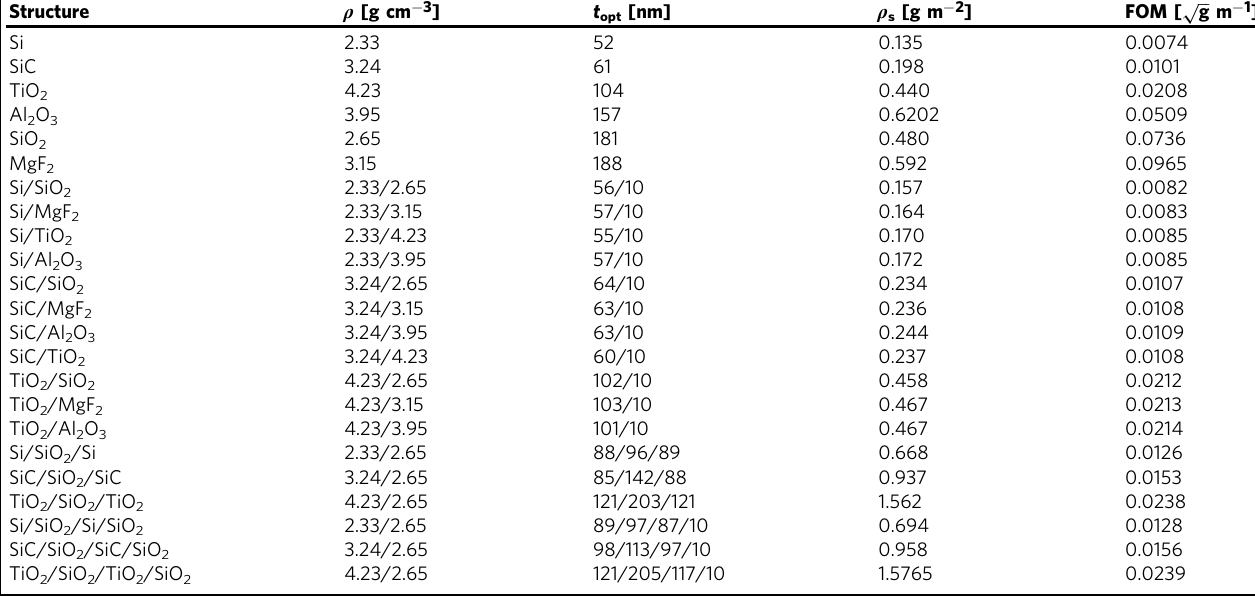
Fig. 2 Optimized FOM values from different multilayer. a structures based on material 1 /vacuum. b structures based on material 1 /material 2 . The simulations are performed for an increase number of layers N .